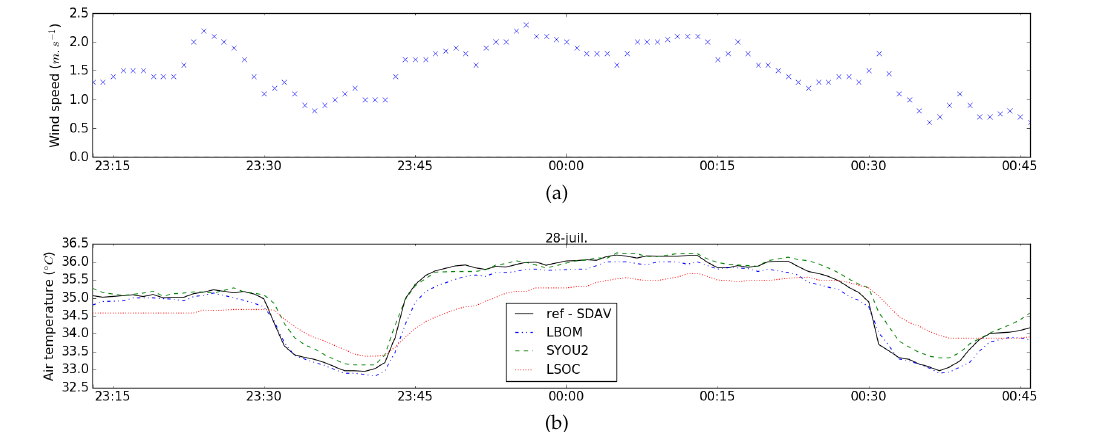
Figure 10. Evolution of the ( a ) wind speed, ( b ) air temperature within several shelters during the night of 28 July